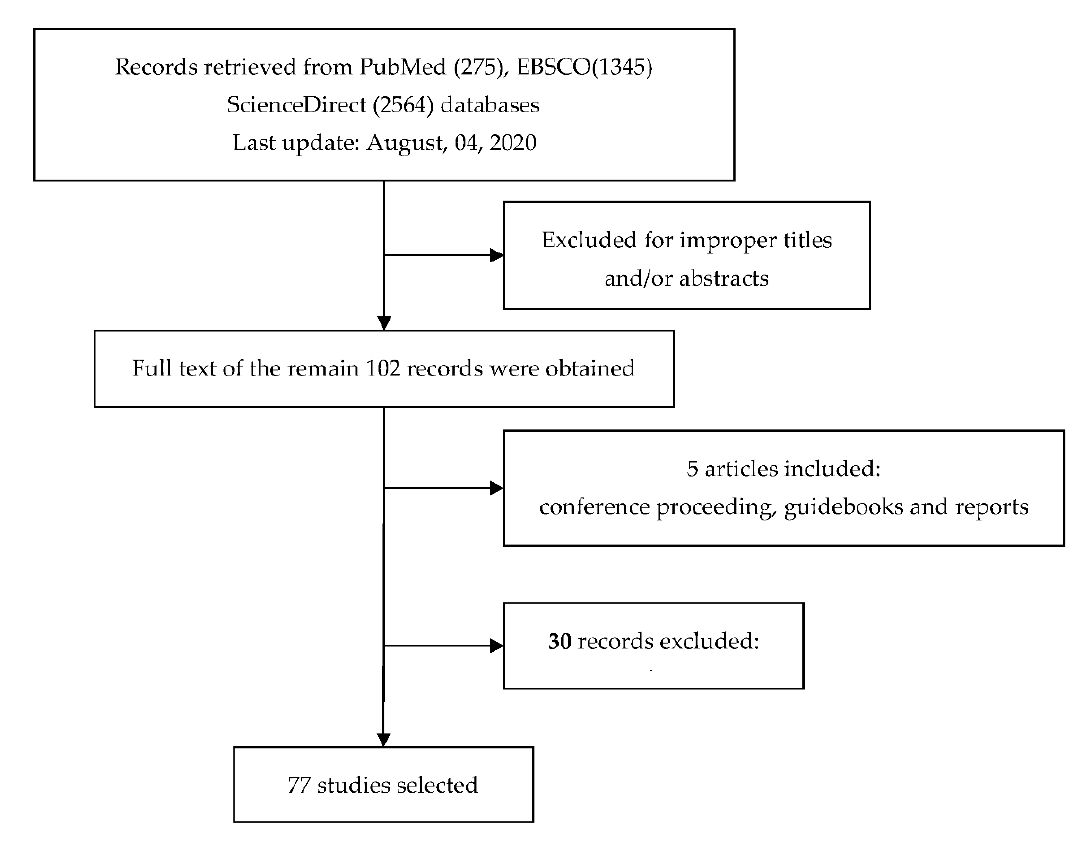
Figure 1. Flow diagram of the systematic review.